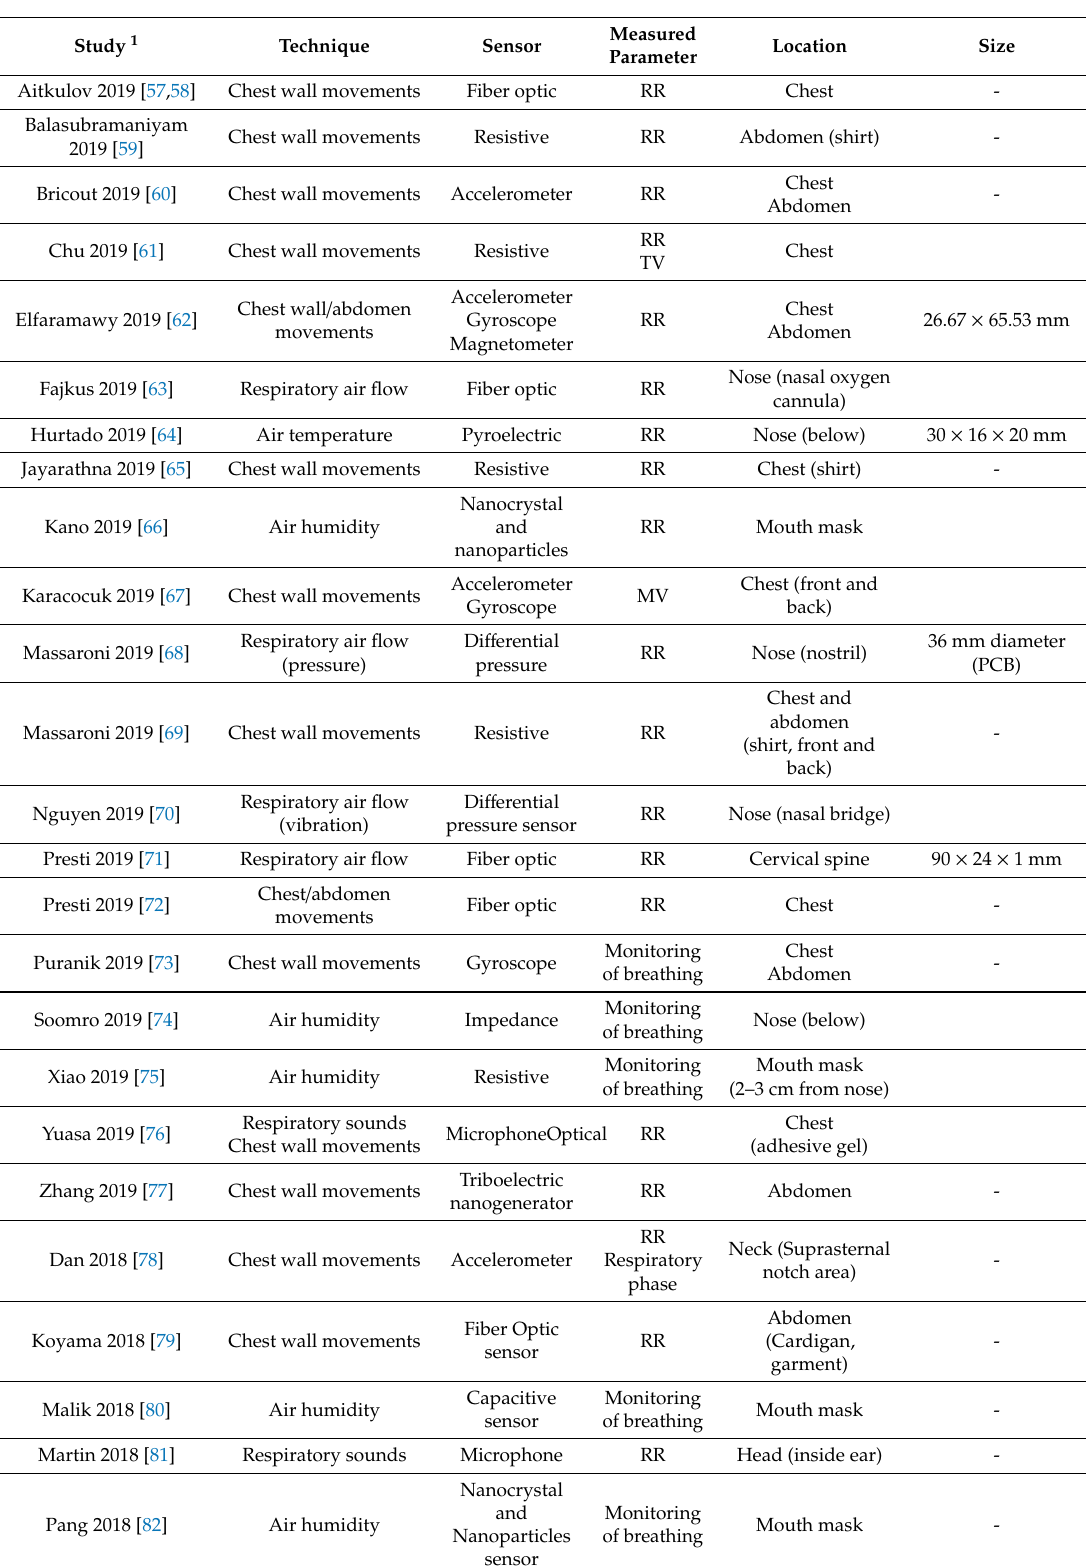
Table 1. Analysis of techniques, sensors, breathing parameters, and sensor locations and sizes for studies of the wearable